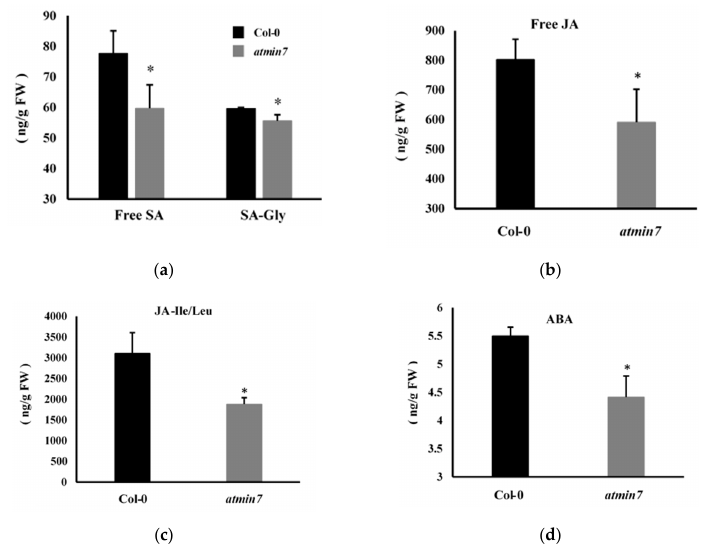
Figure 7. The atmin7 mutant plants accumulated lower levels of salicylic acid (SA), jasmonic acid (JA), and abscisic acid (ABA) relative to WT Col-0 plants. The levels of free SA and SA-Gly ( a ), free JA ( b ), JA-Ile/Leu (JA-isoleucine/leucine) ( c ), and ABA ( d ) were quantified in the leaves of four-week-old WT and atmin7 plants. The experiment was repeated twice with similar results, and the mean +/- SD from the two biological replicates are shown. Significant differences between WT and atmin7 plants were determined by Student’s t -test (* p < 0.05). FW indicates the fresh weight.